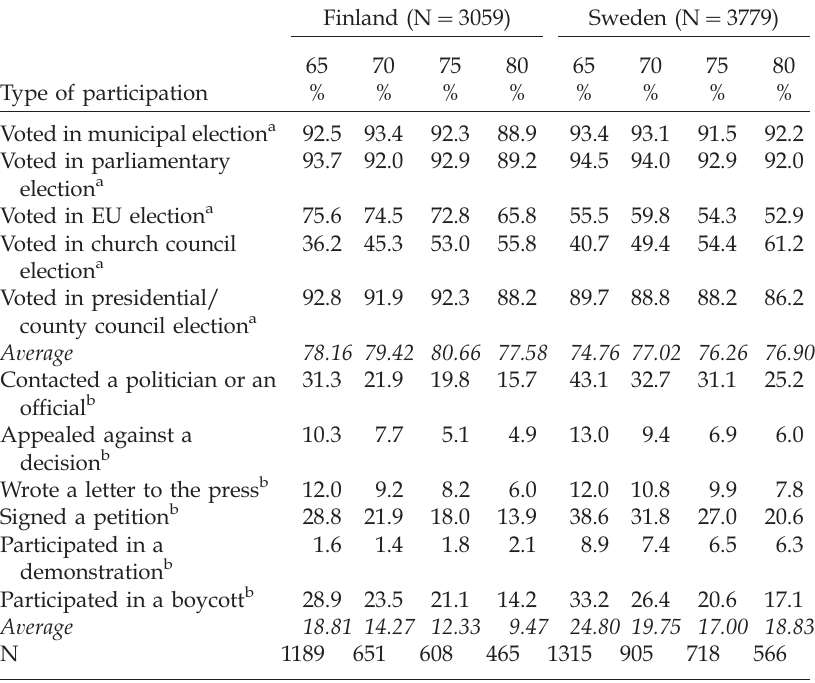
Table 2. Participation in different types of political acti v ities (as a percentage) by country and age group (N (cid:3) 6838) Finland (N (cid:3)